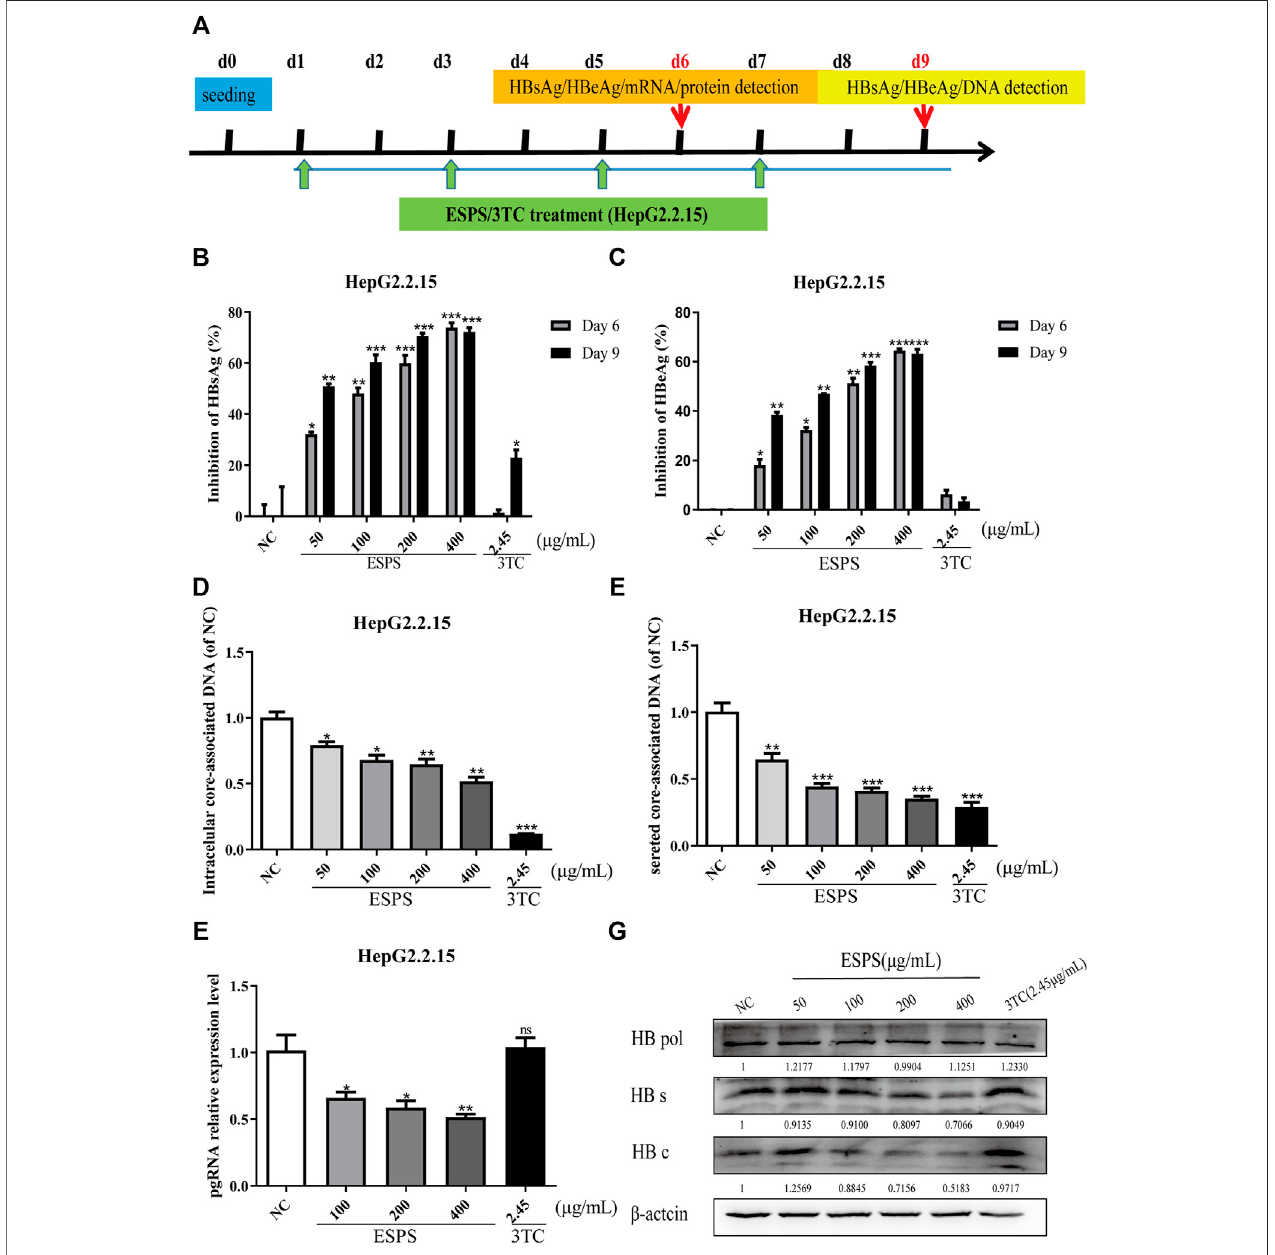
FIGURE 1 | Inhibitory effects of ESPS on HBV in vitro . (A) Experimental process of inhibiting HBV by ESPS in vitro . HepG2.2.15 cells were seeded at day 0, after treatment with ESPS at indicated concentrations, HBsAg (B) , HBeAg (C) in the supernatant of HepG2.2.15 cells were measured by ELISA on the sixth and ninth days. qPCR was used to detect the levels of intracellular core-associated DNA (D) , secreted core-associated DNA (E) on the ninth day, and HBV mRNA (F) on the sixth day. Western blotting analysis was used to detect the levels of HBV protein (G) on the sixth day. 3TC was used as positive control. Values are means ± SD ( n = 3). * p < 0.05, ** p < 0.01, *** p < 0.001 vs . the normal control